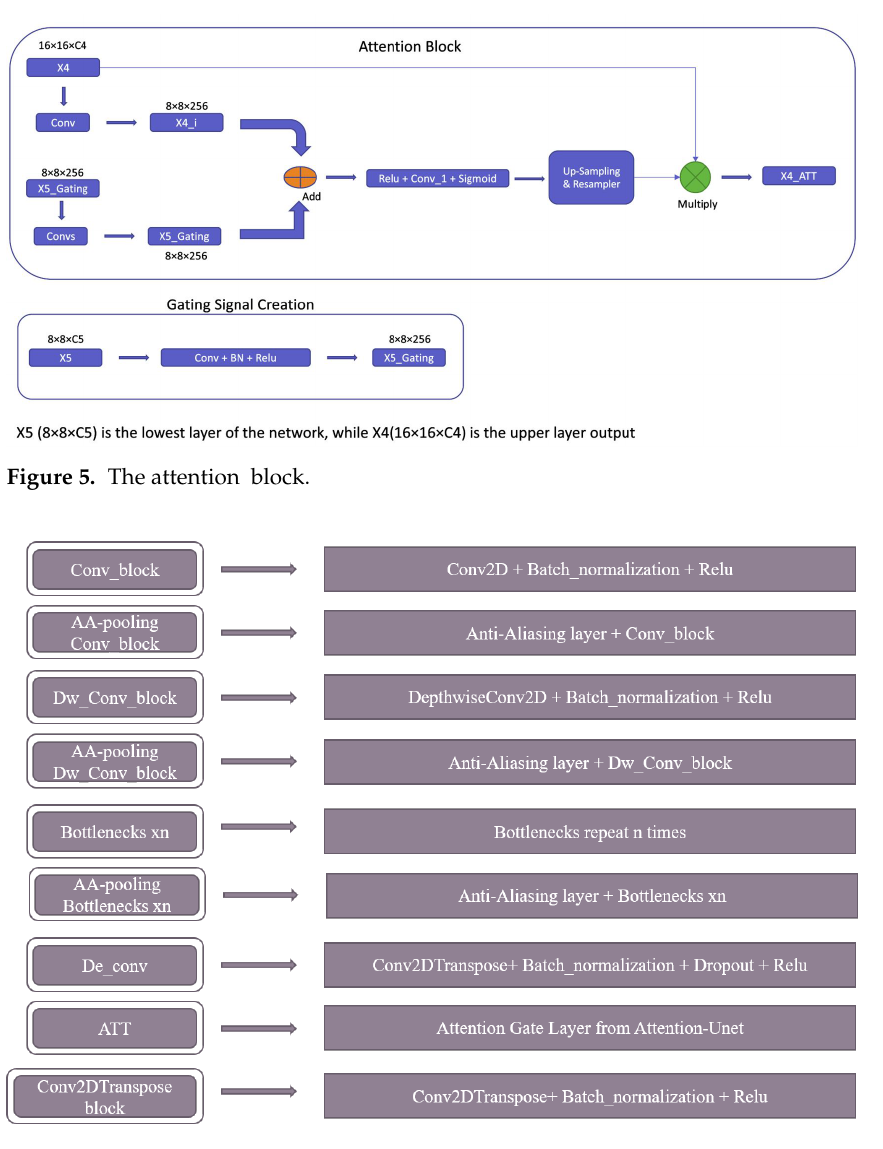
Figure 6. The model’s